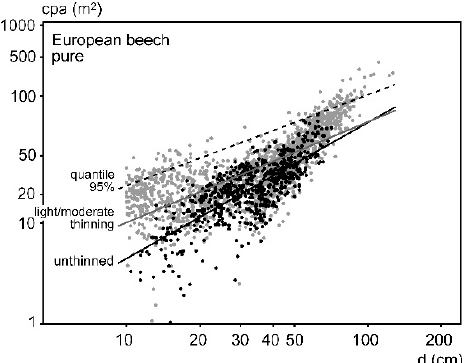
Figure 9. Allometric relationship between tree crown projection area, cpa, and stem diameter, d, of European beech derived from crown measurements on long-term experimental plots in Germany. As the database includes solitary trees as well as trees in thinned and unthinned stands, the ln(cpa) – ln(d) relationships were derived for solitary trees (upper line: 95%-quantile regression: ln(cpa) = 1.11 + 0.92 ln(d) ), for trees in moderately heavily (B/C-grade, n = 1685) thinned stands (middle line: ln(cpa) = 0.05 + 1.01 × ln(d) ), and for trees in unthinned stands (A-grade, n = 661) (lower line: ln(cpa) = −1.59 + 1.36 × ln ( d ) ).